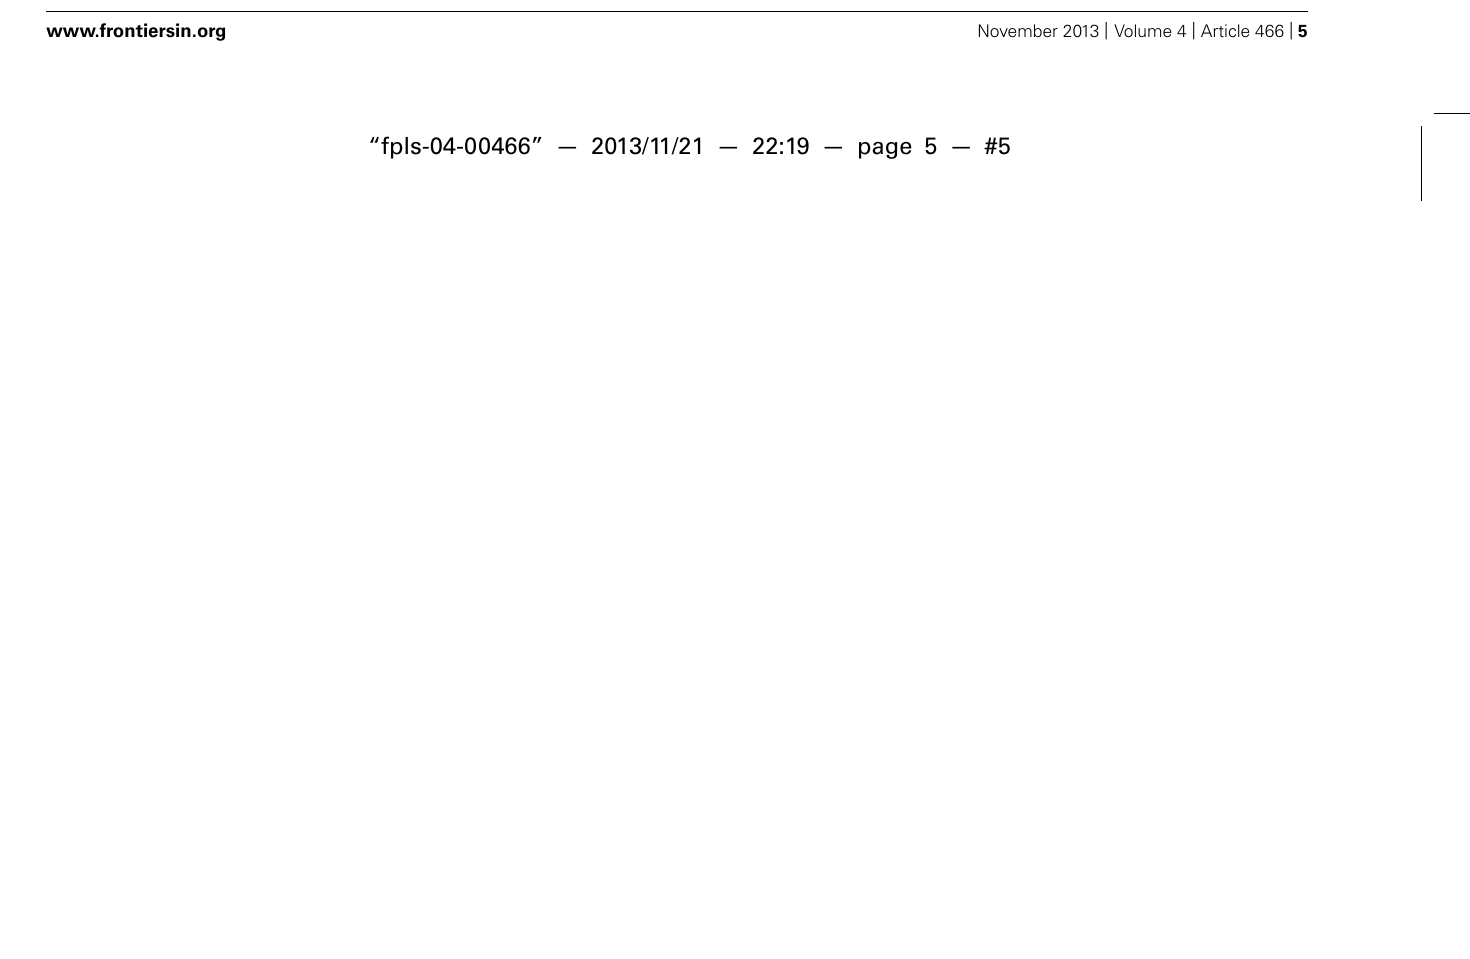
FIGURE 3 | Relative top-kill susceptibility of subalpine tree species with surface fires involving the bark flammability of subalpine trees ( φ ) versus the critical time for cambium kill ( τ c ). This latter was computed from bark thickness (BT) using the Peterson and Ryan’s function (1986). As φ and τ c (or BT) covaried significantly ( p < 0.001,